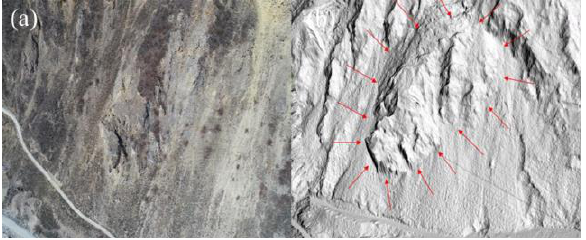
Figure 5. (a) is an optical remote sensing image, (b) is a dangerous rock mass found after removing vegetation from airborne LiDAR